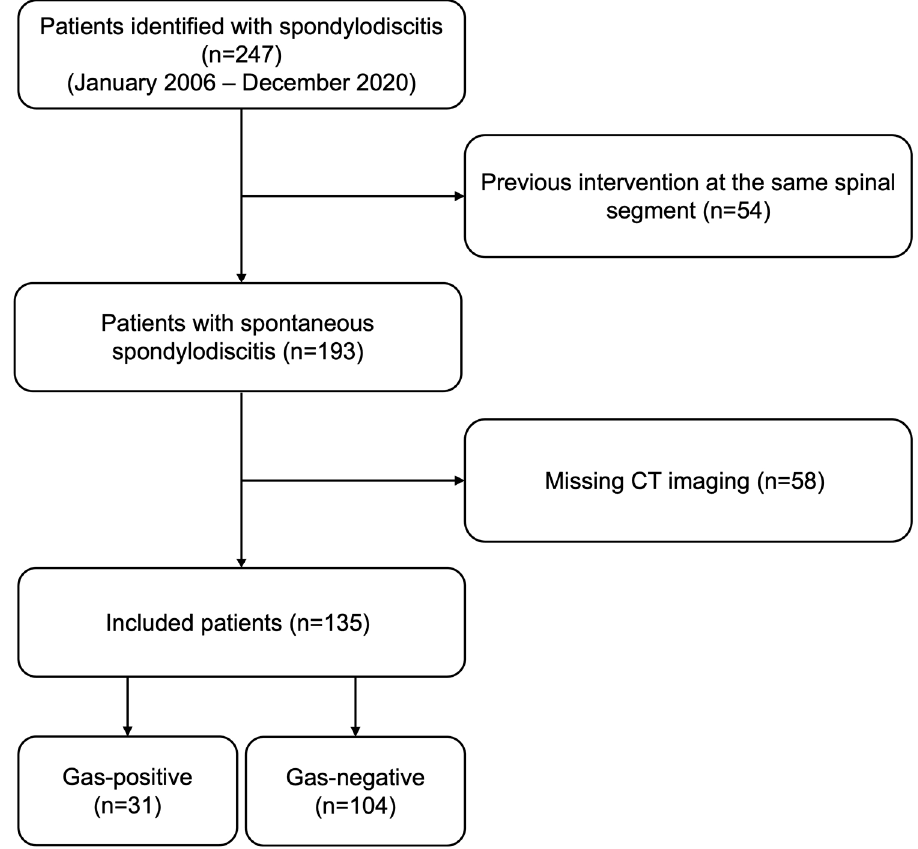
Figure 1. Flow chart of patient inclusion.